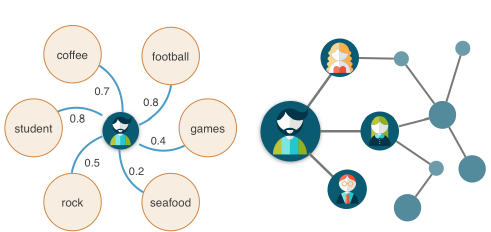
Figure 2: a) User profile and b) User FOAF Network